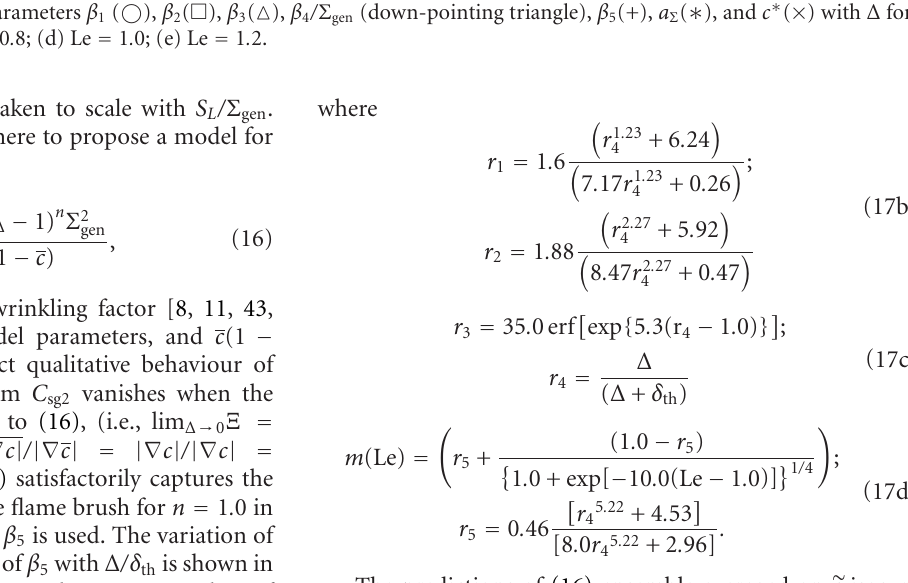
The predictions of (16) ensemble averaged on (cid:2) c isosur- faces are compared with ensemble averaged values of C sg2 in Figure 5 for all cases at Δ = 0 . 8 δ th and Δ = 2 . 4 δ th , which show that (16) satisfactorily predicts the statistical behaviour of C sg2 when n is taken to be n = 1 . 0 and the optimum value of β 5 is used. According to (17a)–(17d), β 5 approaches to asymptotic values for large values of Δ